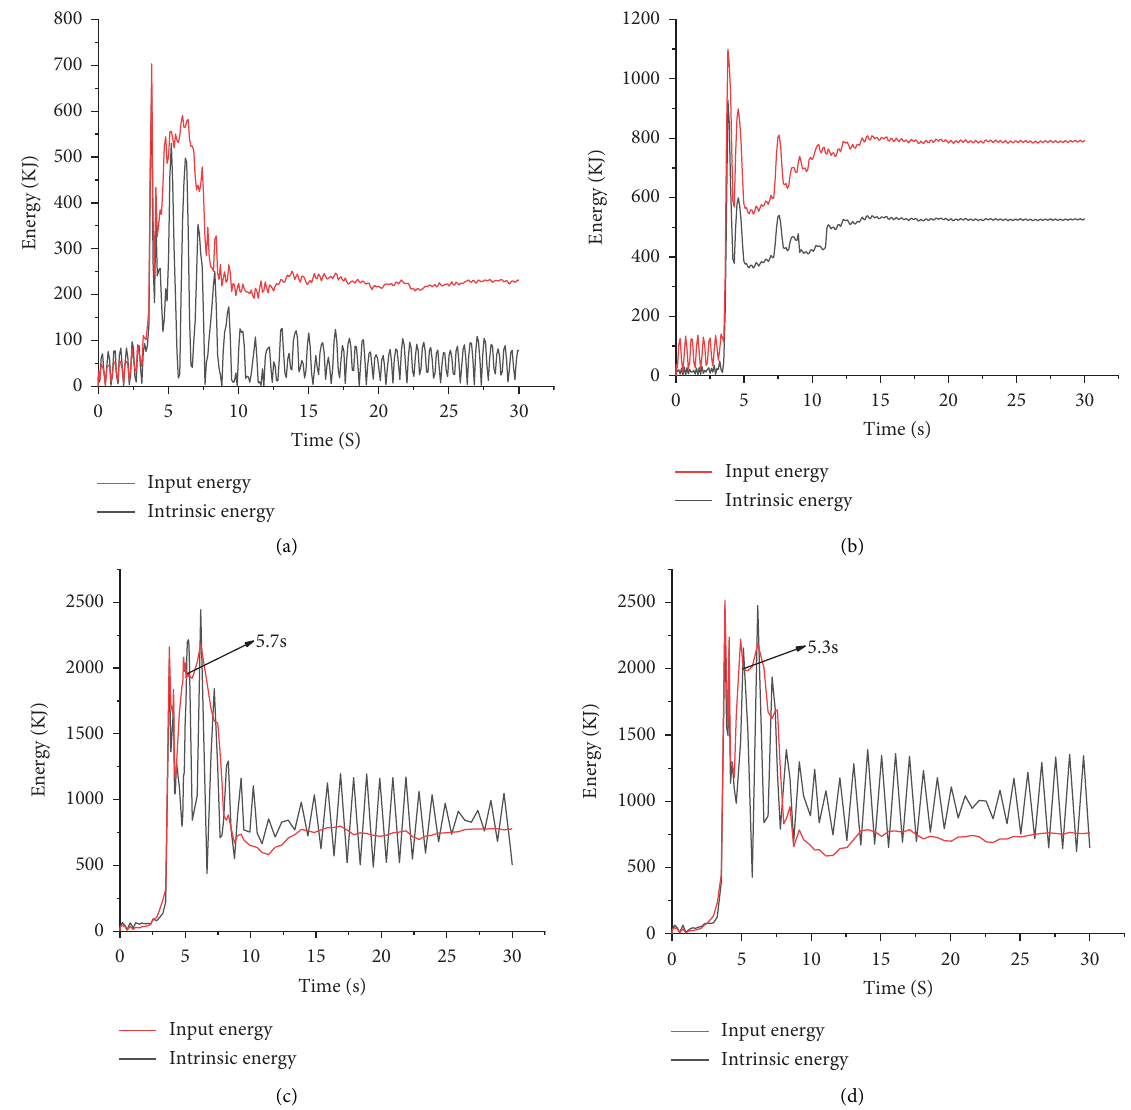
Figure 22: Time-history curves of efective characteristic energy and efective input energy of aqueduct structure under diferent working conditions. (a) Condition 1. Dynamic stability. (b) Condition 2. Dynamic stability. (c) Condition 3. Dynamic instability. (d) Condition 4. Dynamic